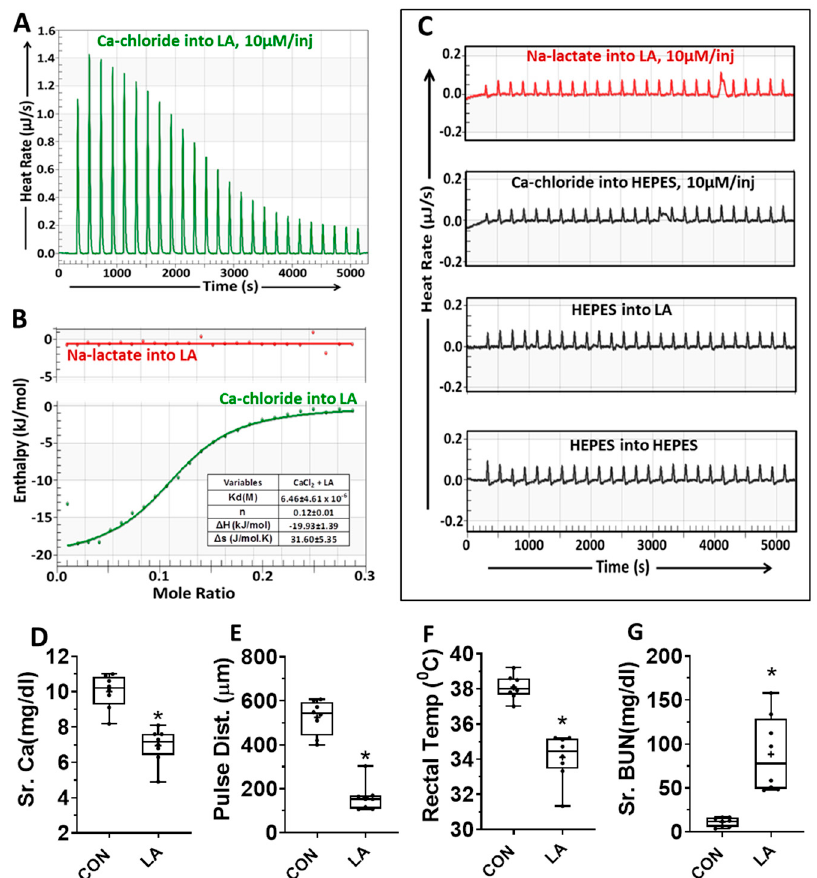
Figure 1. A–C: Isothermal titration calorimetry showing Linoleic acid (LA) reacts with calcium but not lactate. ( A ) Thermogram showing heat rate of injection of calcium chloride (10 µM/injection) into 1 mM Linoleic acid (LA). Both were dissolved in 10 mM HEPES (pH 7.4) ( B ) Enthalpograms of injection of sodium lactate (Na-lactate, red line on top) or calcium chloride (CaCl 2 ; green line below) into linoleic acid. The various thermodynamic variables (Mean ± SD (standard deviation)) from three different experiments are mentioned in the table adjacent to the thermogram. ( C ) Thermogram showing heat rate of injection of sodium lactate (top, red line; 10 µM/injection) and other control experimental conditions below this (black lines). D–G:Effects of intraperitoneal administration of linoleic acid (LA, 0.1% body weight) to CD-1 mice on their serum calcium ( D ), carotid pulse distension (pulse dist.) ( E ), rectal temperature ( F ), and blood urea nitrogen (Sr. BUN) ( G ). The vitals were measured at 40 h, and blood parameters at necropsy.* indicates a p -value of <0.05 on Mann-Whitney test.